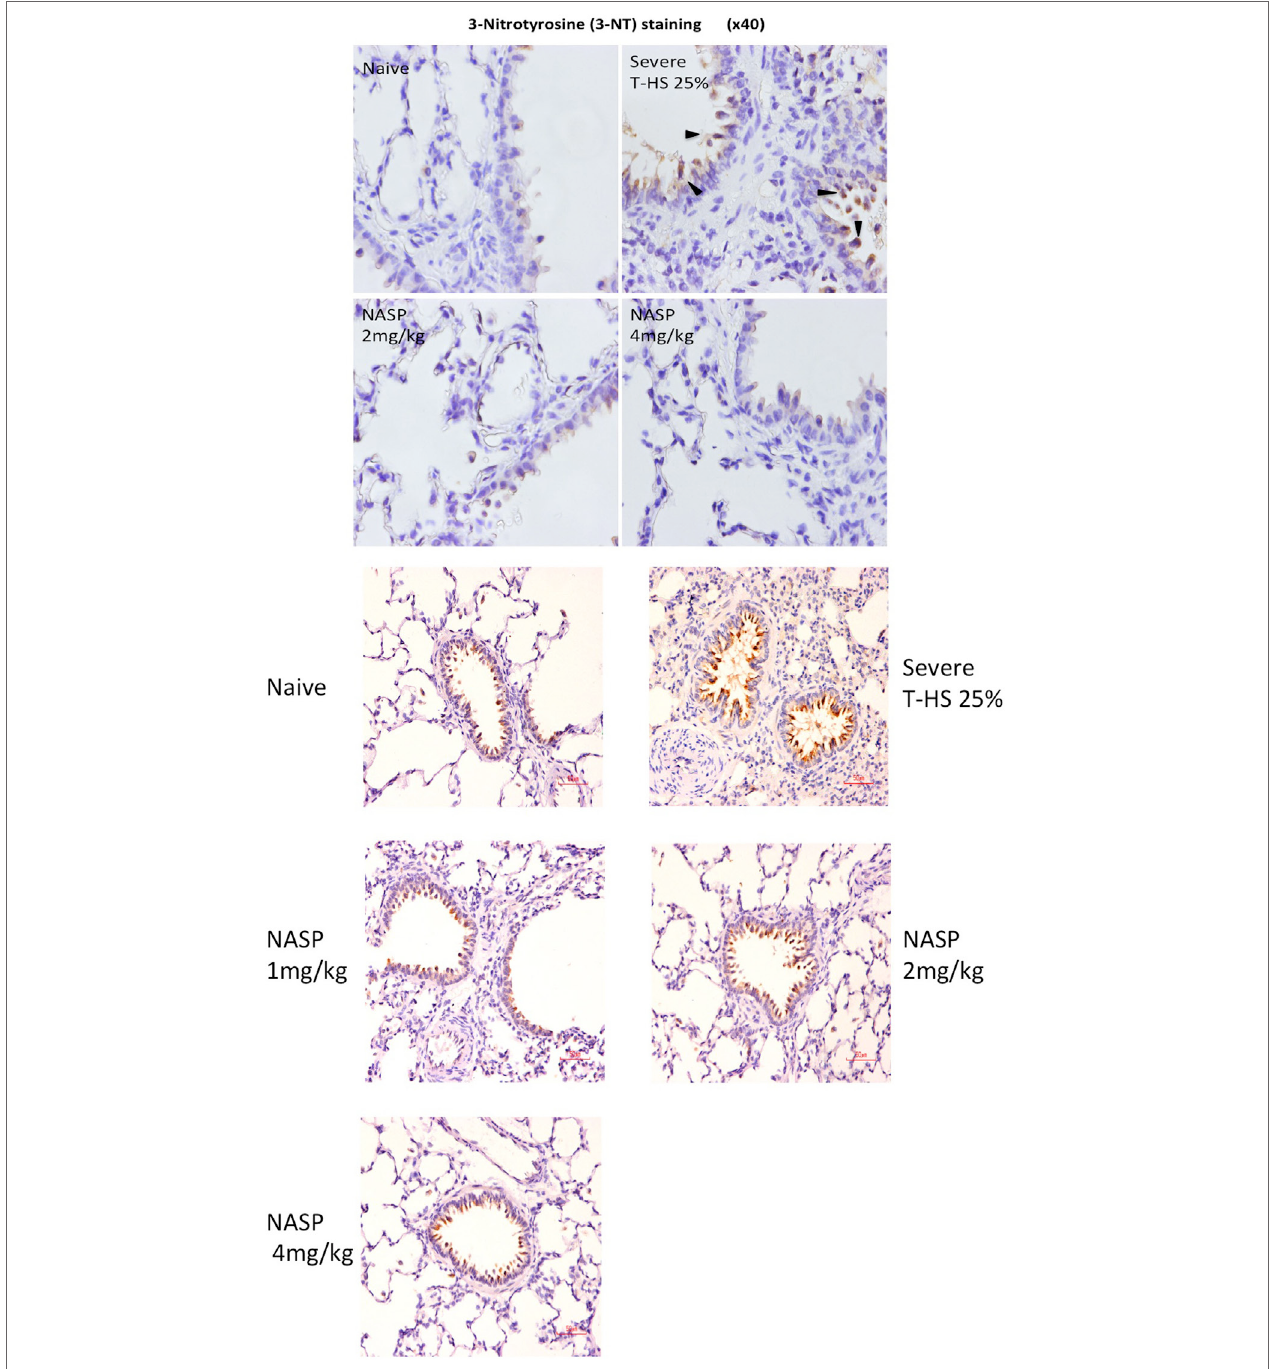
FigUre 9 | Nucleic acid scavenging polymer (NASP) (hexadimethrine bromide) treatment of rodent T-HS improved lung histological appearances. Staining for 3-nitrotyrosine (3-NT), a marker of peroxynitrite production and hence oxidative stress, was used to evaluate oxidative injury. There was a dose-dependent improvement in lung histological appearance with increasing doses of NASP (not quantified). Black arrows indicate 3-NT-positive stained cell. Red scale bar represents 50